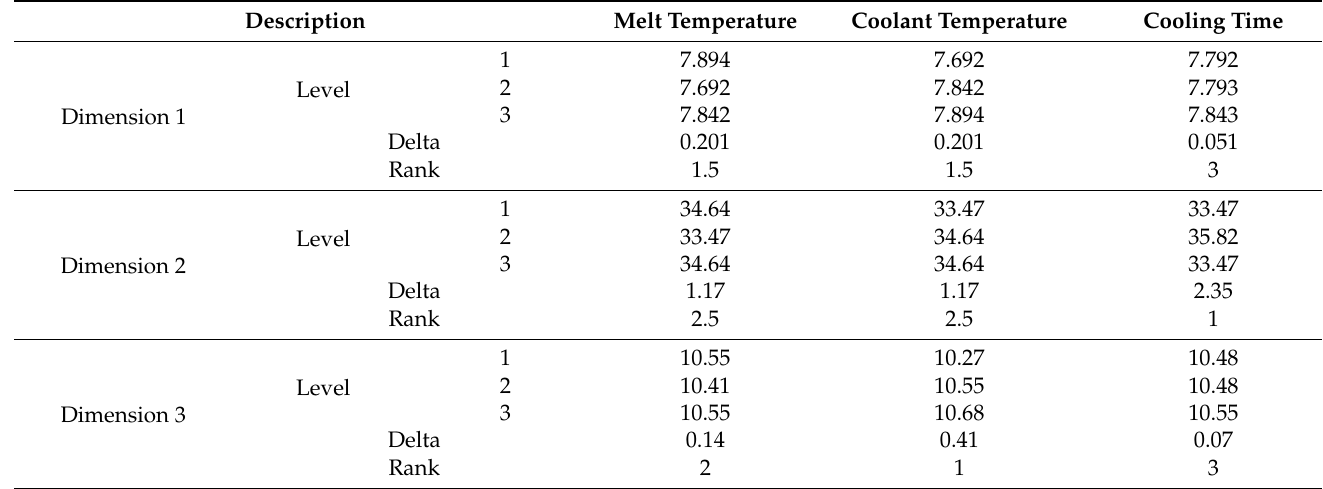
Table 16. Average of S/N ratio for each level of factors in the pivot sub-assembly.